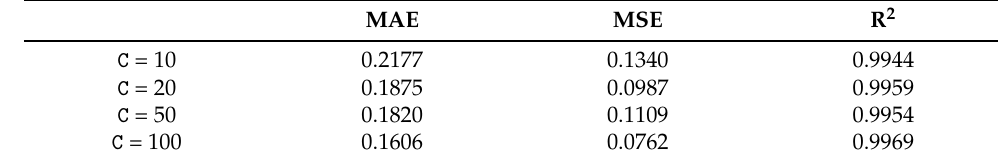
Table 3. The errors of AdaBoost + SVR.